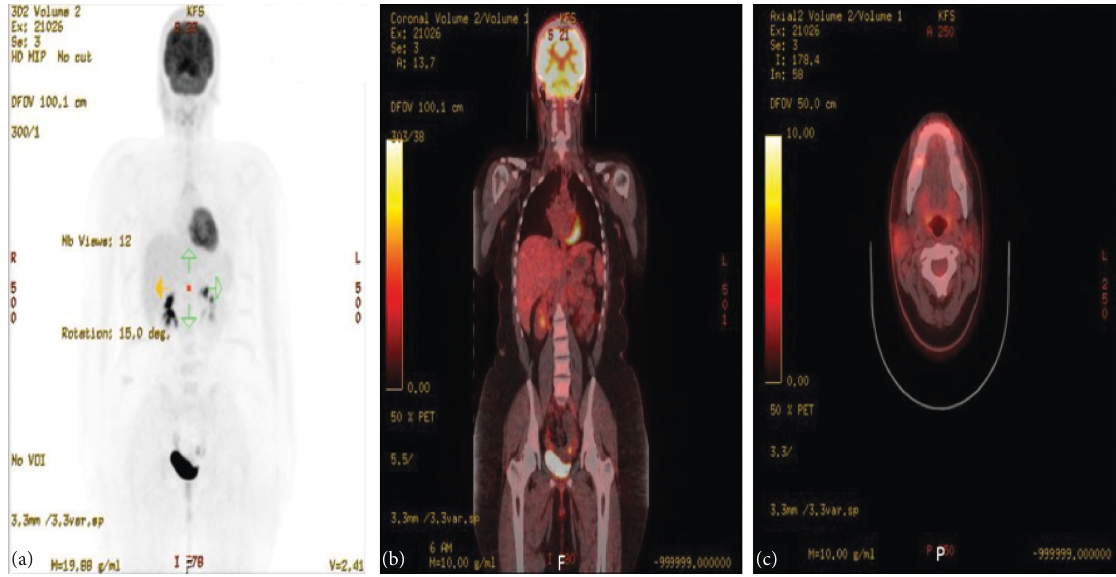
Figure 3: The PET scan in November 2017. (a)–(c) There is mild background level FDG avidity (SUVmax 2.2) in the region of the right parotid. This uptake is most likely postsurgical. Also, there is mild FDG avidity (SUVmax 1.7) within a few prominent (up to 11mm short axis) right upper cervical (levels II-III) lymph nodes. The exact etiology remains indeterminate (i.e., whether could be malignant or reactive due to her recent surgery). Also, small volume lymph nodes (measuring up to 8mm short axis) are present in the left upper cervical/level II region, with minimal FDG uptake, as this is a common site for reactive lymphadenopathy. On the other hand, there are additional small volume bilateral submental and submandibular lymph nodes (up to 6 mm short axis) with no definite FDG uptake. Uptake of the tracer elsewhere is within physiological limits.